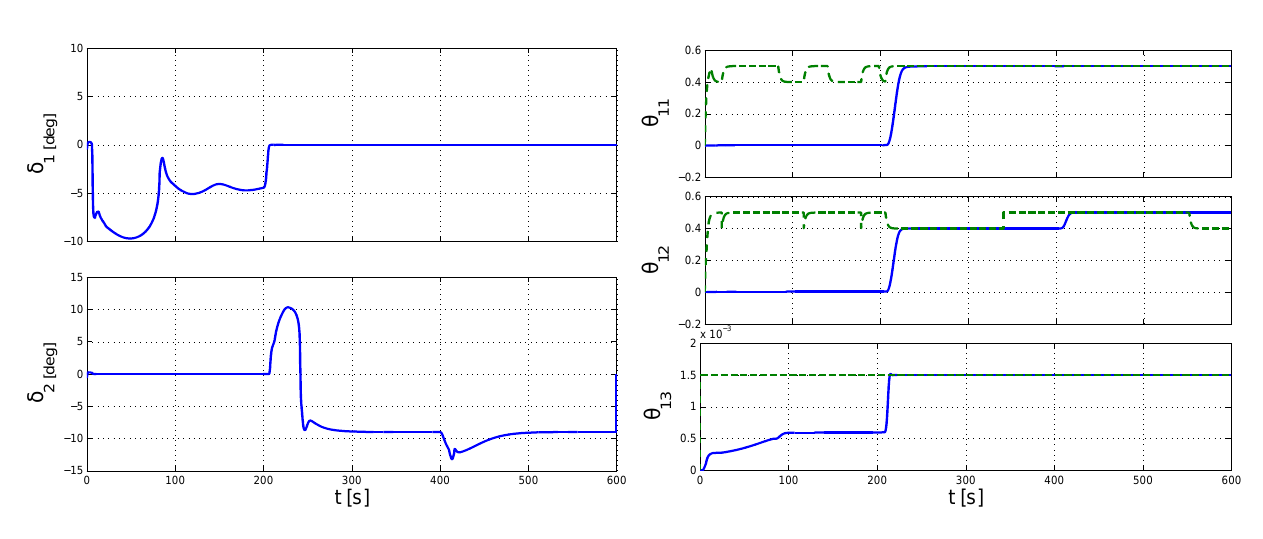
Figure 6: Actual (dashed) and estimated (solid) loss parameters